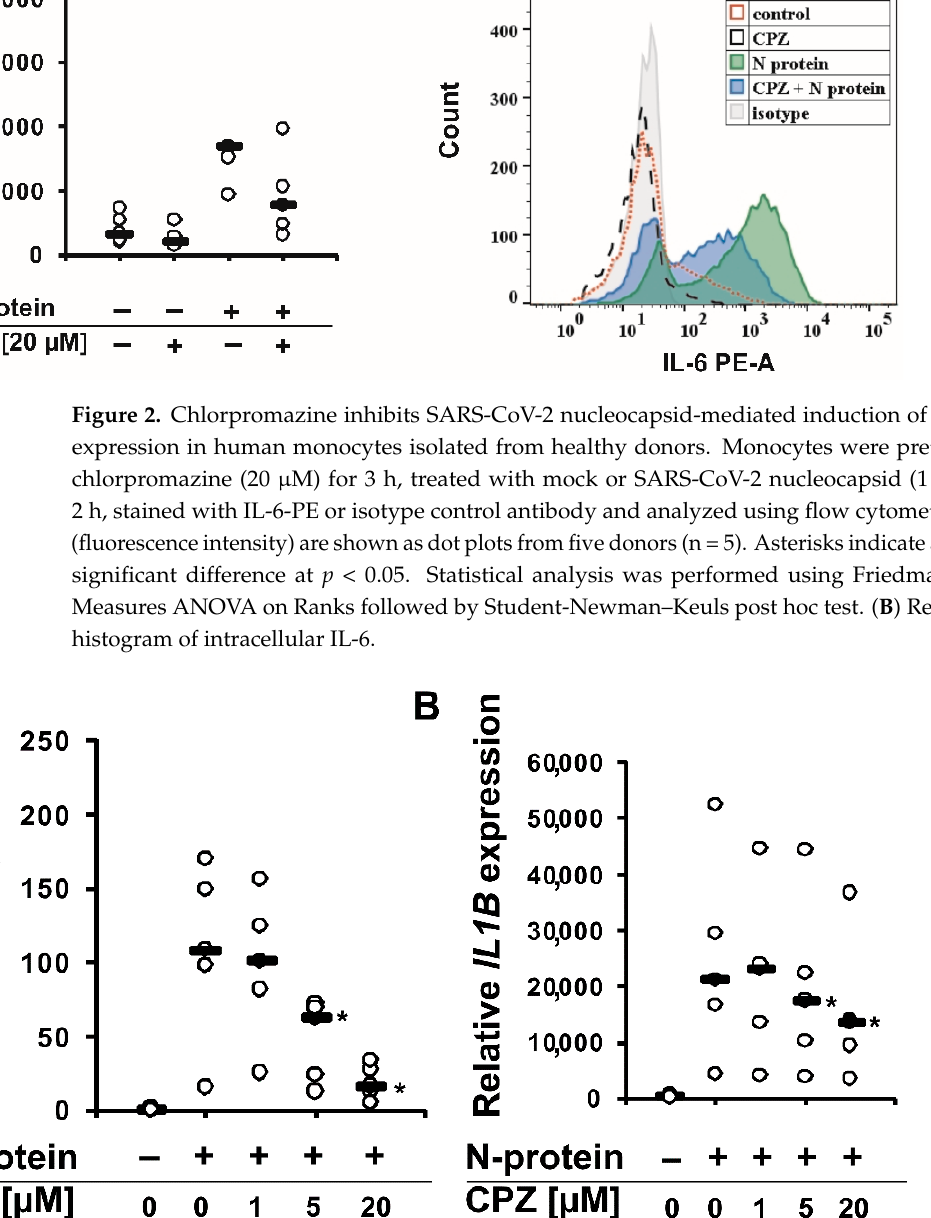
Figure 3. Chlorpromazine inhibits the SARS-CoV-2 nucleocapsid-mediated induction of IL6 and IL1B mRNA expression in human monocytes isolated from healthy donors. Human monocytes were pretreated with the indicated chlorpromazine concentrations for 3 h, and after that time, the cells were stimulated with 1 μ g/mL SARS-CoV-2 nucleocapsid for 48 h. Then, the cells were collected for RNA extraction. IL6 ( A ) and IL1B ( B ) mRNA expression was determined by RT–PCR and normalized to averaged reference mRNA levels of the housekeeping genes HPRT1 , HMBS , and RPL13A . Data are shown as dot plots with median values from five independent donors (n = 5). Asterisks indicate a statistically significant difference at p < 0.05. Statistical analysis was performed using Friedman Repeated Measures ANOVA on Ranks followed by Student-Newman–Keuls post hoc test.